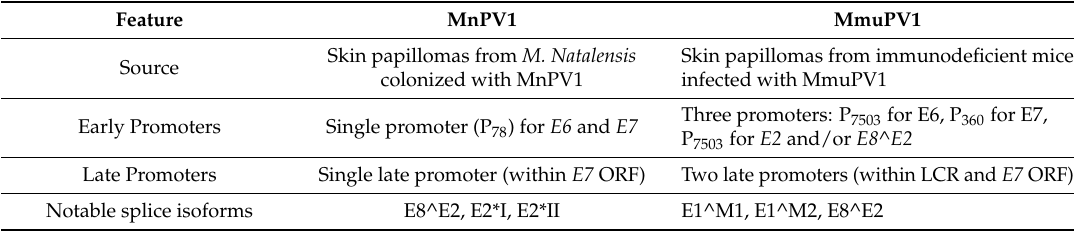
Table 5. Key features of MnPV1 and MmuPV1 transcript